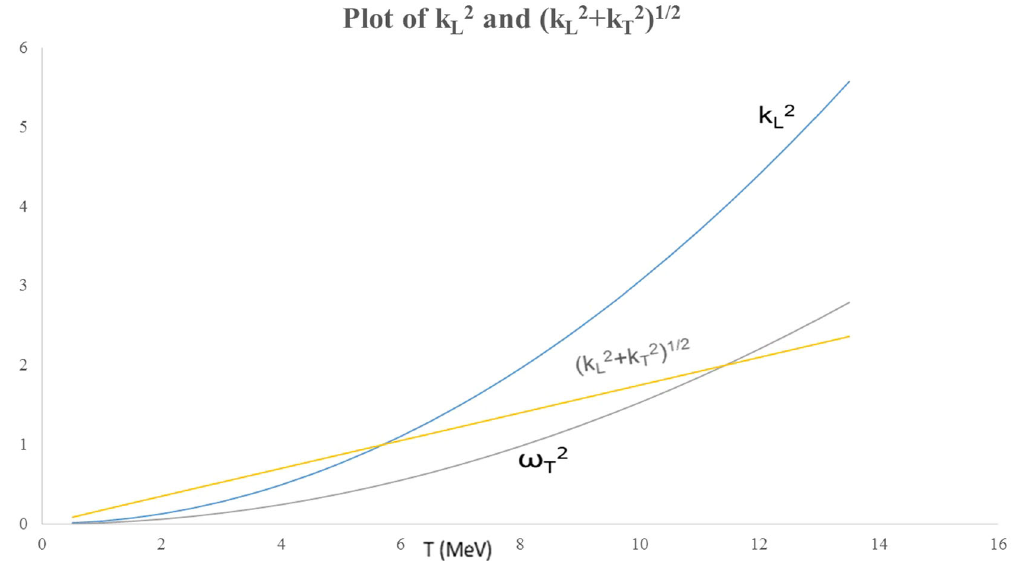
Fig. 3 Comparison of the plots of k; the magnitude of the propagation vector, longitudinal propagation K 2